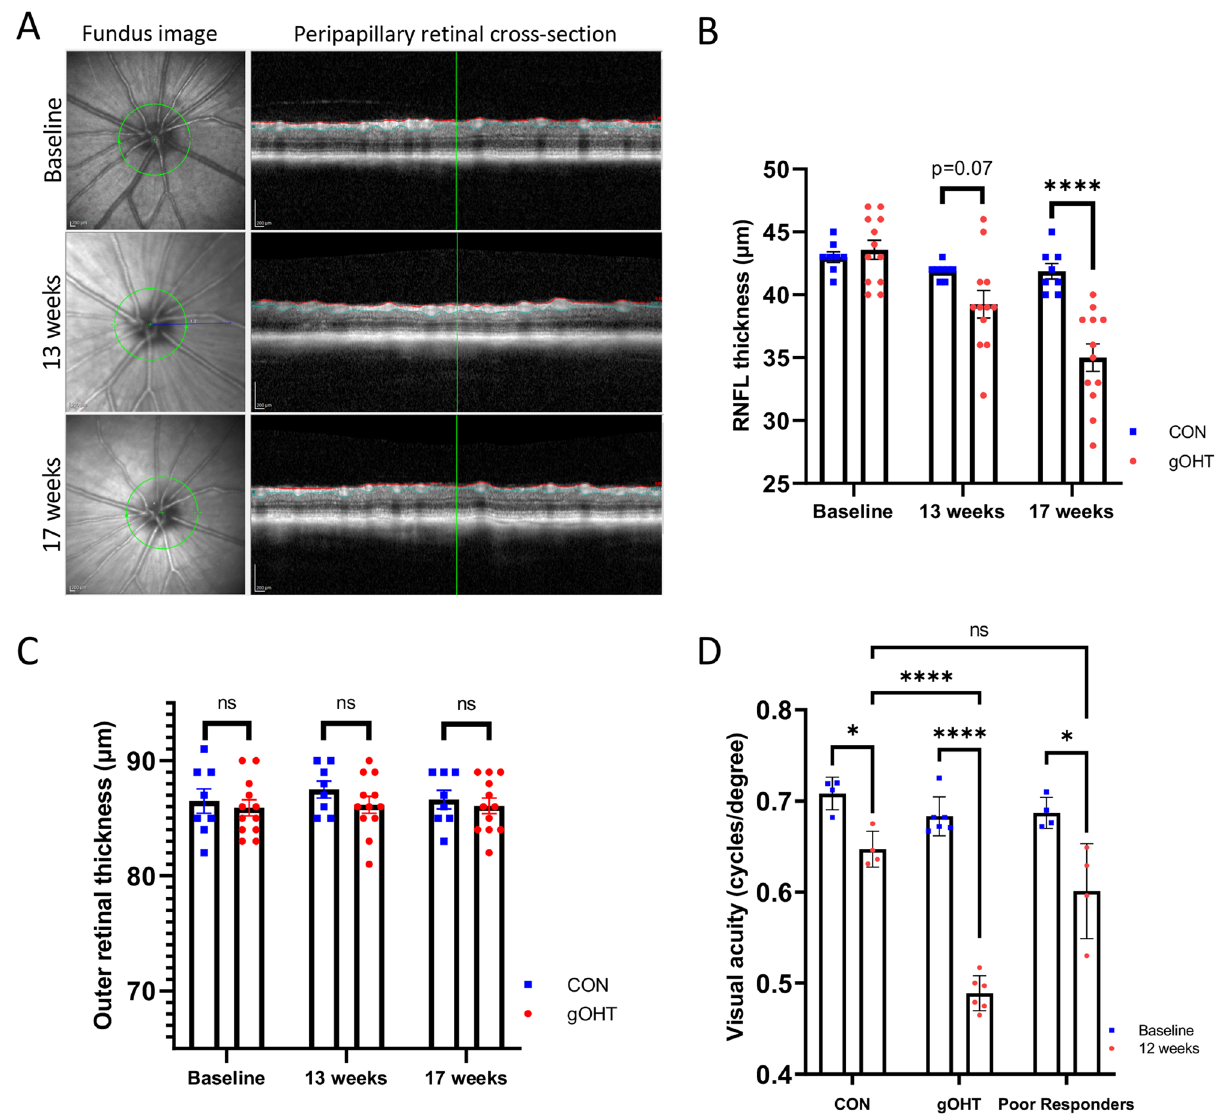
Figure 2. The gOHT model results in progressive RNFL thinning and decreased vision. ( A ) Representative fundus and corresponding cross-sectional OCT images used to measure the RNFL thickness at baseline, and at 13 and 17 weeks after surgery (scale bars represent 200 μm). The green circle represents the cross-sectional circumference and red and blue tracings outline the RNFL. ( B ) Quantified RNFL thickness measurements indicate progressive thinning in the gOHT group compared to CON that became highly significant after 17 weeks. ‘Snugly’ sutured eyes that showed a poor IOP response were excluded from the gOHT group (n = 8 and 12 for CON and gOHT, respectively, ****p < 0.0001, bars are SE). ( C ) Outer retinal thickness measured using OCT did not show statistically significant change at any time point (ns; not significant, bars are SE). ( D ) Comparison of visual acuity after 17 weeks (12 weeks of elevated IOP) in CON and gOHT groups shows a highly significant difference. However, there was a statistically significant decrease in vision in all groups post- suturing (p < 0.05). Notably, animals that responded poorly in terms of IOP elevation post-suturing did not show a statistically significant difference from CON (n = 4, 6 and 4 for CON, gOHT, and poor responders, respectively, ****p < 0.0001, *p < 0.05, bars are SE). RNFL, retinal nerve fiber